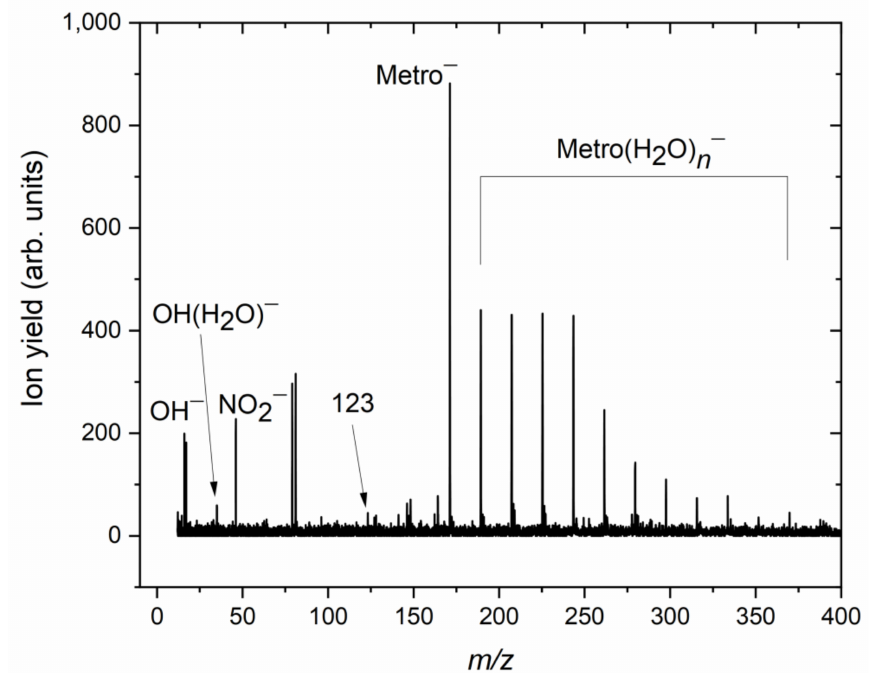
Figure 4. The negative ion mass spectrum for Metro clustered with water. The spectrum was obtained by the sum of individual mass spectra recorded in the electron energy range between about 1 and 6 eV in steps of 0.25 eV. The spectrum indicates the parent anion of Metro clustered with n = 1–11 water molecules. The peak at mass-to-charge 123 is assigned to (Metro-NO 2 -2H) − . The other mass peaks not labeled represent background signals.